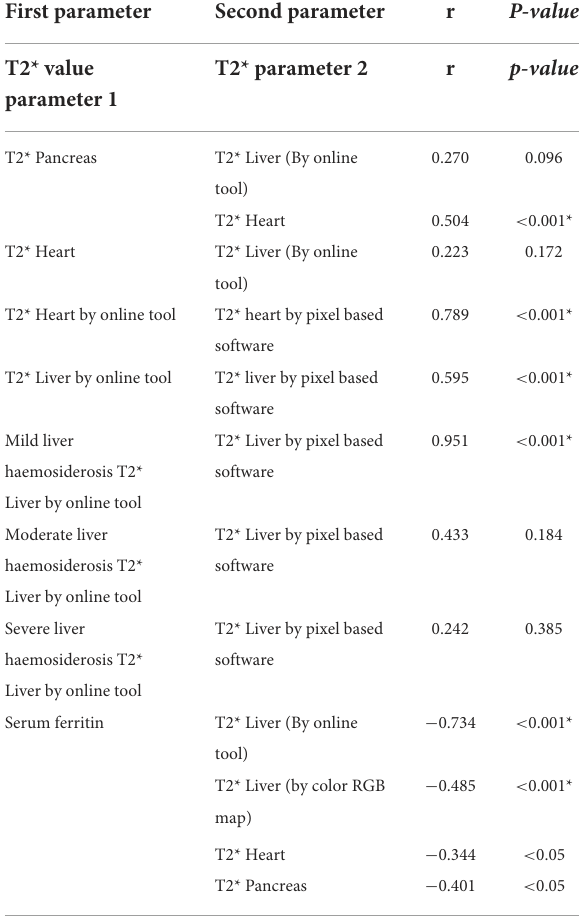
TABLE 2 The spearman correlation between T2 *